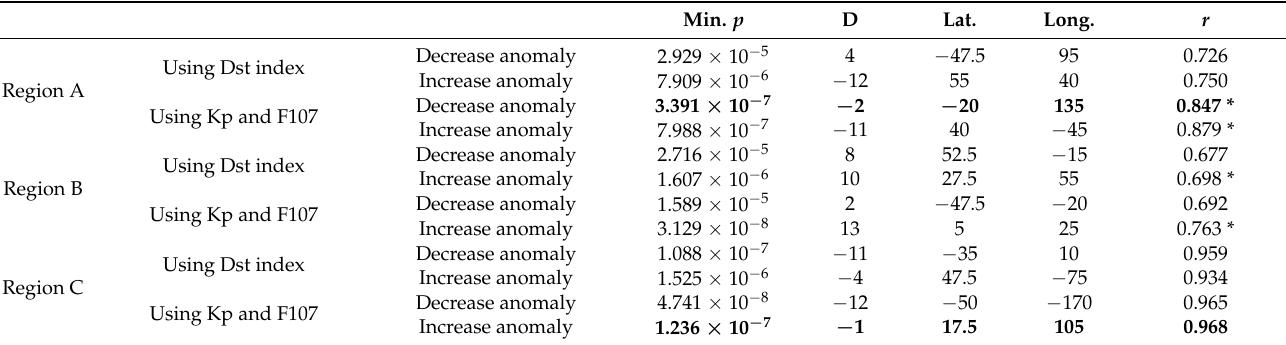
Table 4. The minimum p , associated D, locations, and r for the results of the declustered samples with energy releases ≥ M 5.5 without outliers shown in Supplementary Material S3.